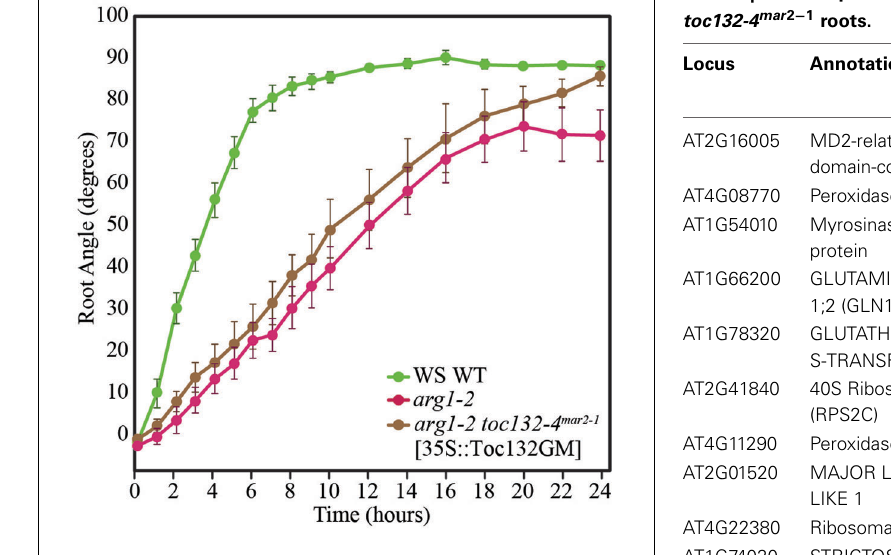
FIGURE 3 | arg1-2 toc132-4 mar 2 − 1 [35S::Toc132GM] plants showed similar root tip reorientation kinetics compared to arg1-2 single mutants but slower kinetics than wild type. The values in degrees for arg1-2 toc132-4 mar 2 − 1 roots, which did not respond to reorientation, for the time points shown on the graph from left to right are − 121 ± 29, − 120 ± 28, − 120 ± 29, − 121 ± 29, − 120 ± 29, − 120 ± 29, − 120 ± 29, − 120 ± 29, − 120 ± 28, − 129 ± 29, − 120 ± 29, − 120 ± 28, − 129 ± 28, − 129 ± 28, − 121 ± 28, − 129 ± 29, − 121 ± 29, and − 120 ± 28. arg1-2 and arg1-2 toc132-4 mar 2 − 1 [35S::Toc132GM] root tip angles were not significantly different from each other at any time point ( p > 0 . 05, Student’s T -Test). The error bars represent the standard error, and n = 10. Similar results were obtained in two additional independent experiments.